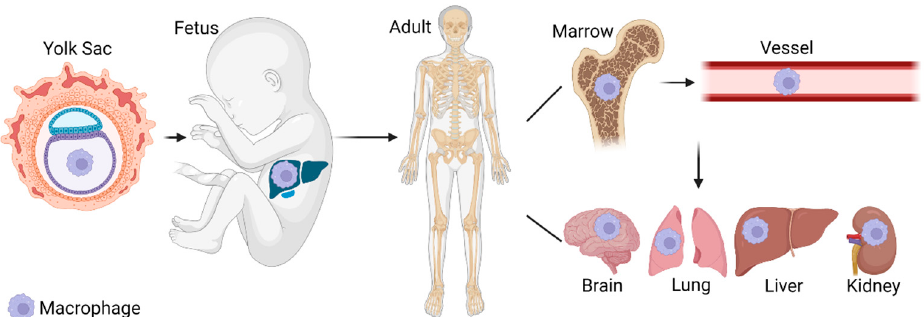
Figure 1. Source of macrophages. Macrophages are originally derived from the yolk sac, mainly from the liver during the embryonic period, and are mainly stored in the bone marrow after delivery. Hematopoietic stem cells in the bone marrow differentiate into macrophages under the action of cytokines and then enter the blood circulation to all parts of the body. In addition to circulating macrophages in the blood, various tissues and organs of the body also contain resident macrophages. For example, microglia in the brain, alveolar macrophages in the lung, Kupffer cells in the liver, and macrophages in the kidney, etc.